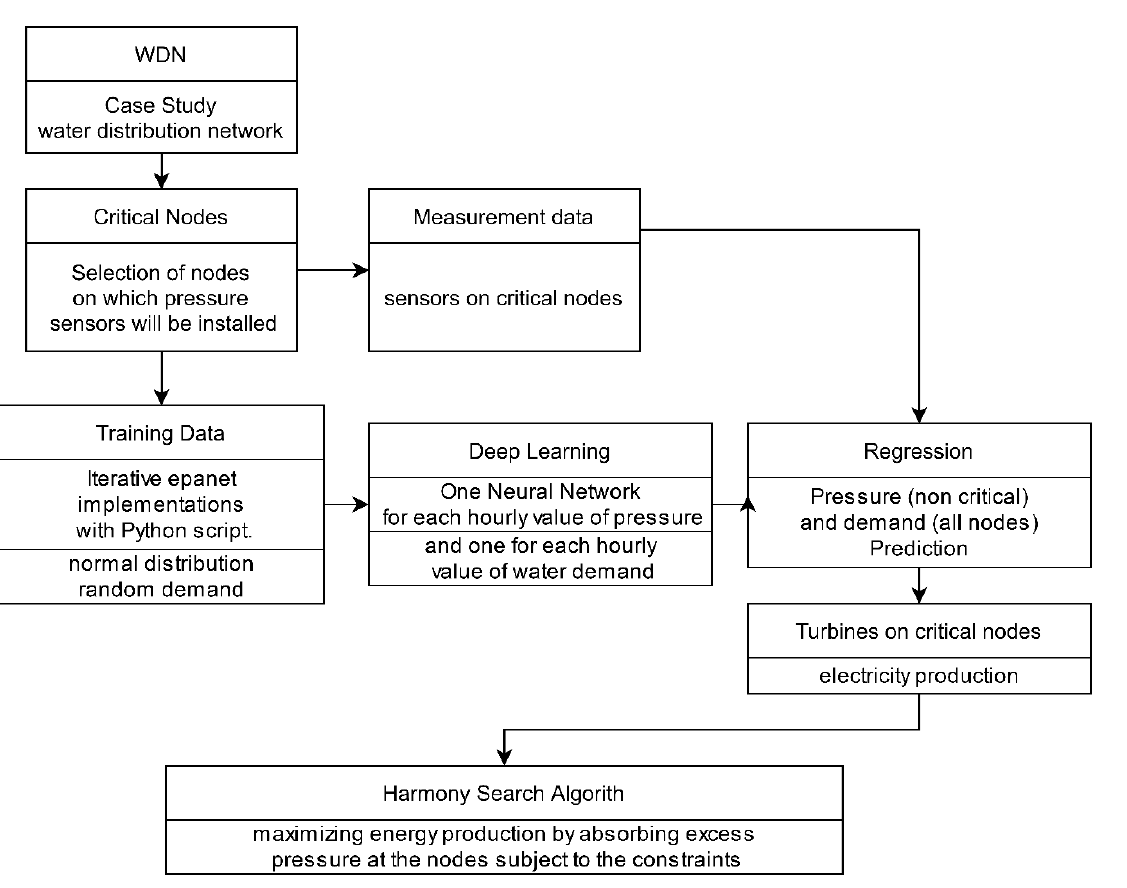
Figure 1. Hierarchical flow diagram of the methodology.